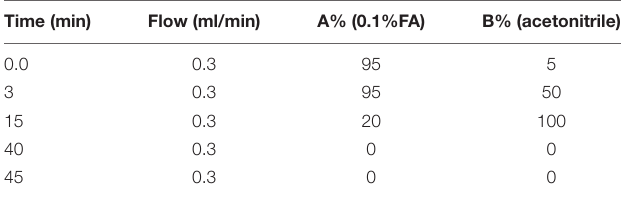
TABLE 1 | The gradient elution program for